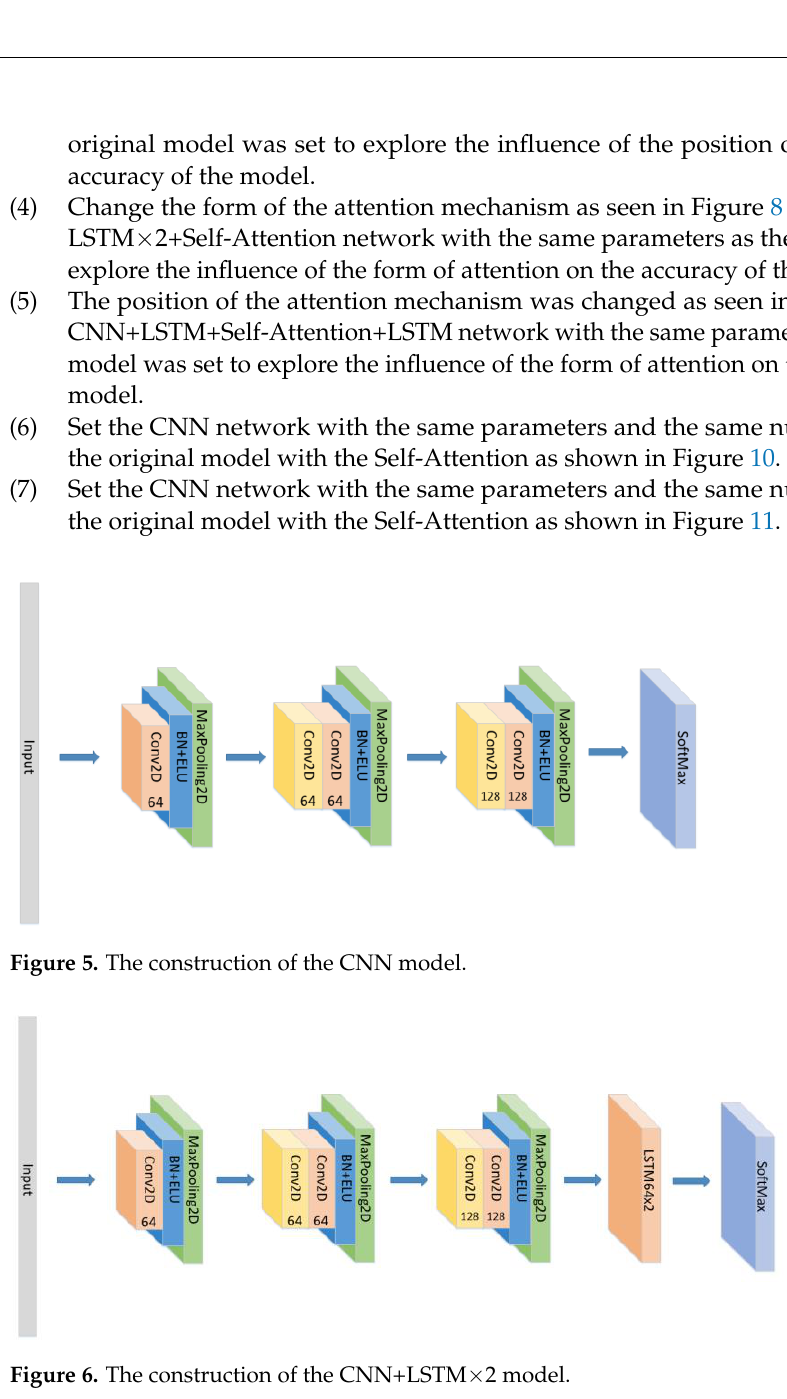
Figure 6. The construction of the CNN+LSTM×2 model.